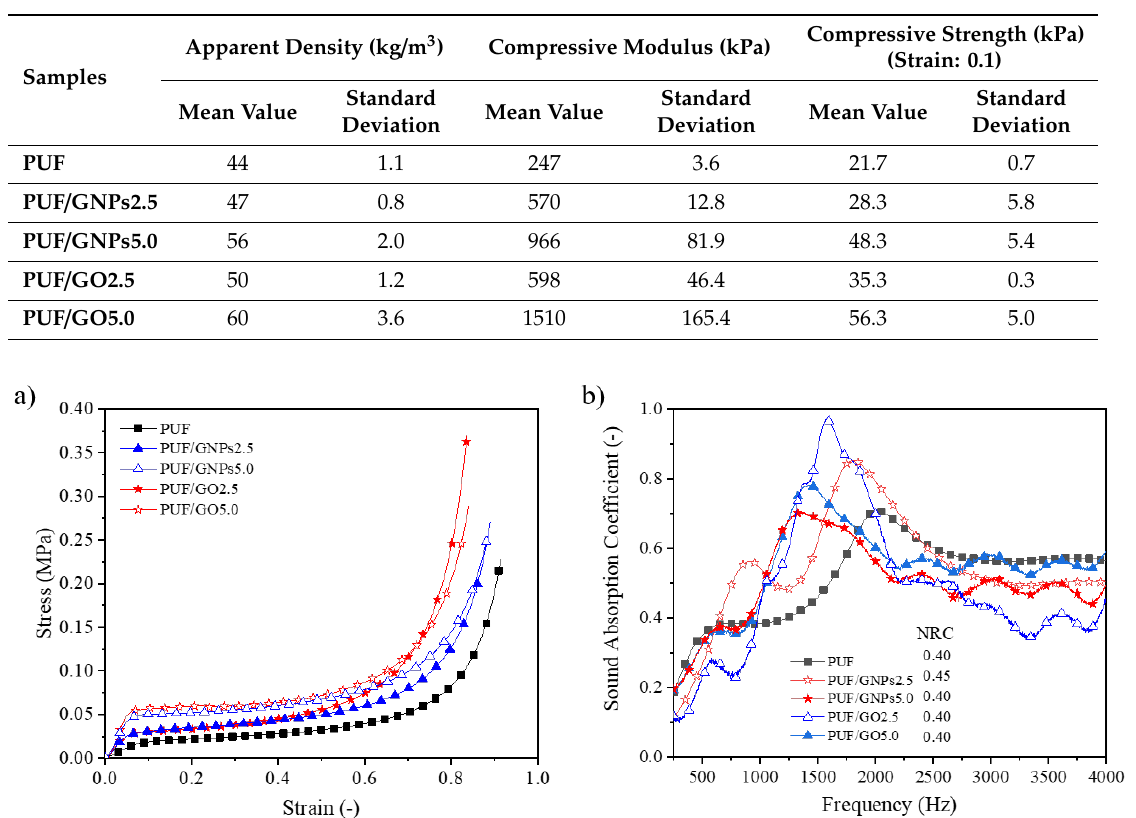
Table 2. Apparent density, compressive modulus, and compressive strength for 10% of deformation (n = 5).